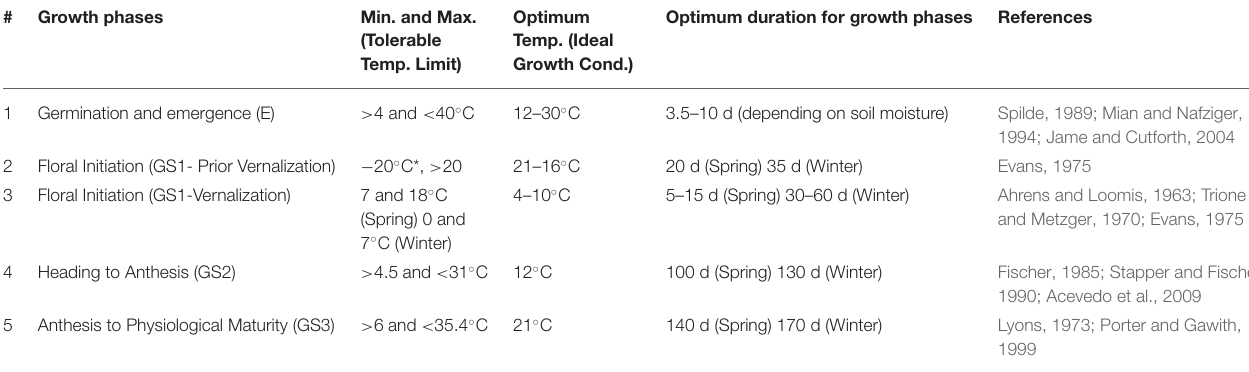
TABLE 1 | Temperature threshold values for various wheat growth